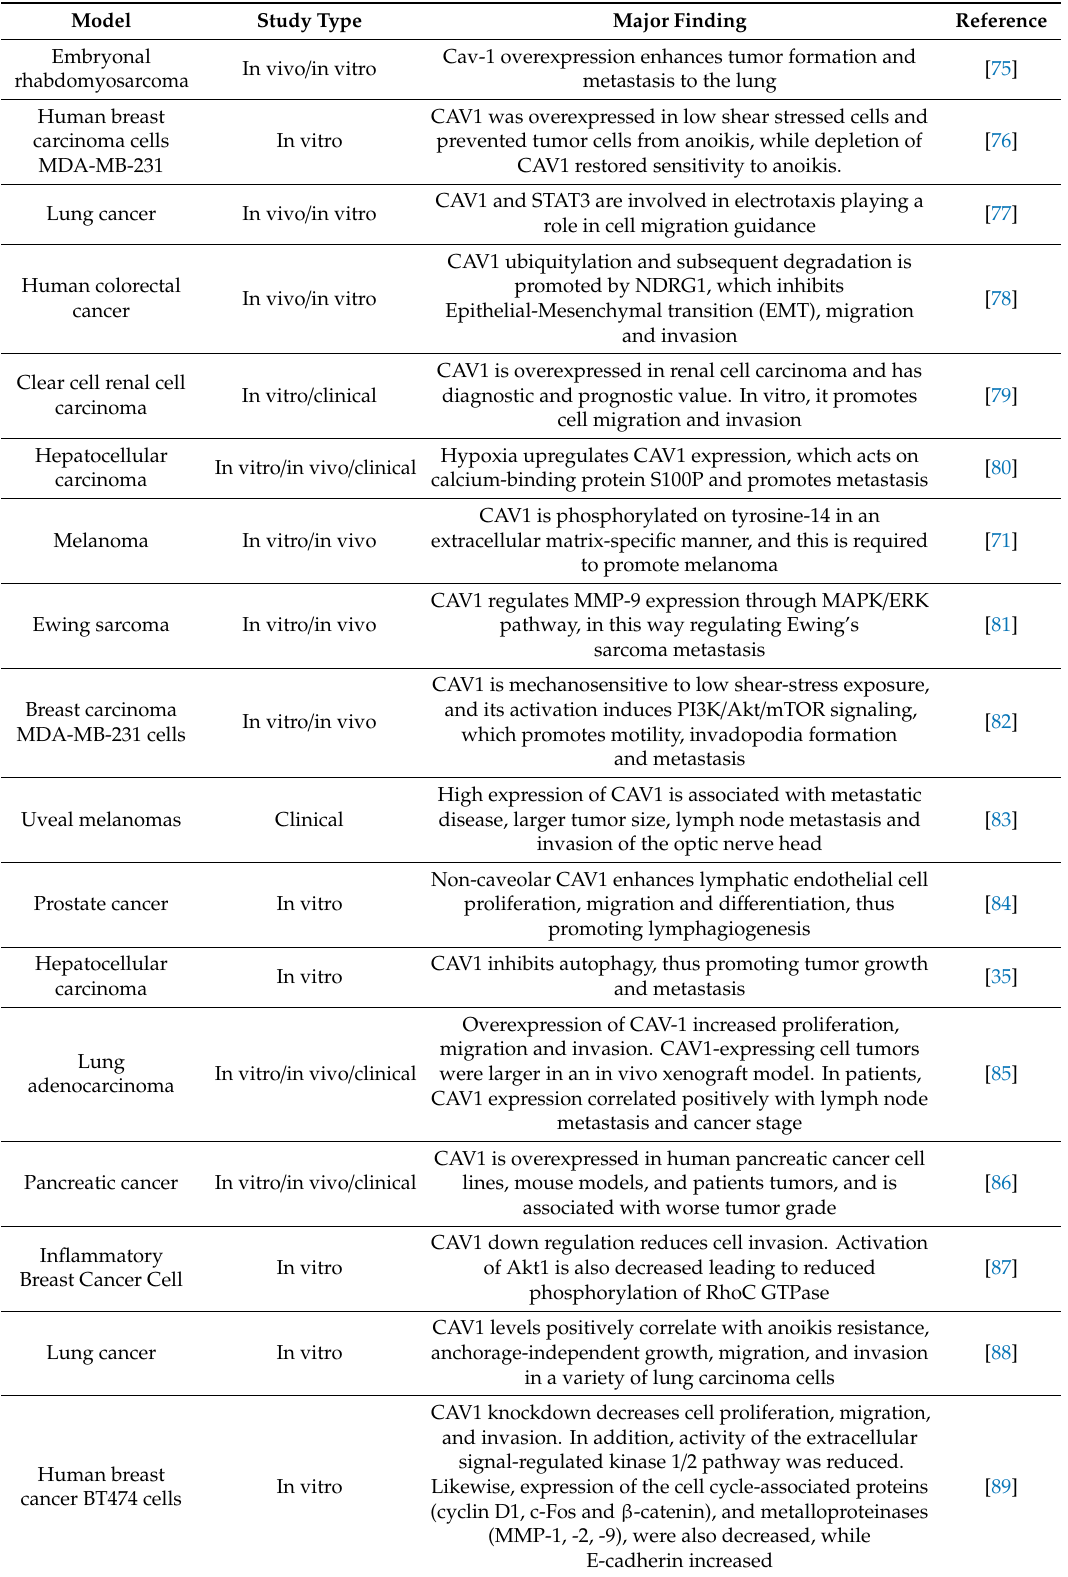
Table 1. Summary of evidence linking CAV1 expression to cancer metastasis. Note that the data summarized here represents an update on related information provided in a table published in